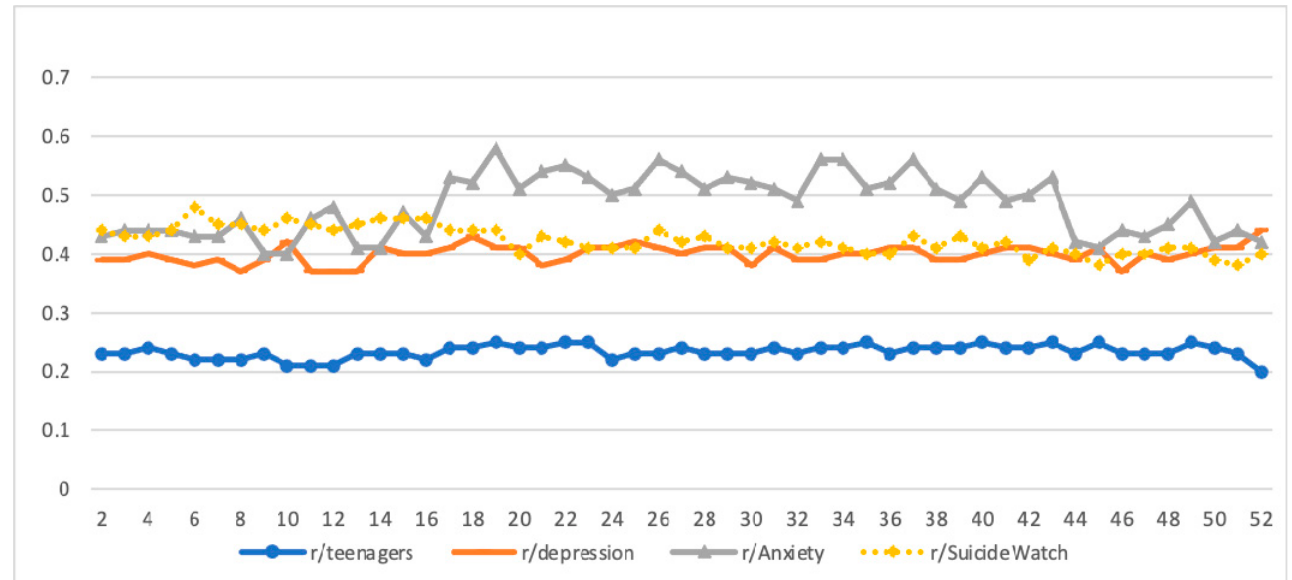
Figure 3. Weekly negative emotion levels in posts/comments by subreddit.